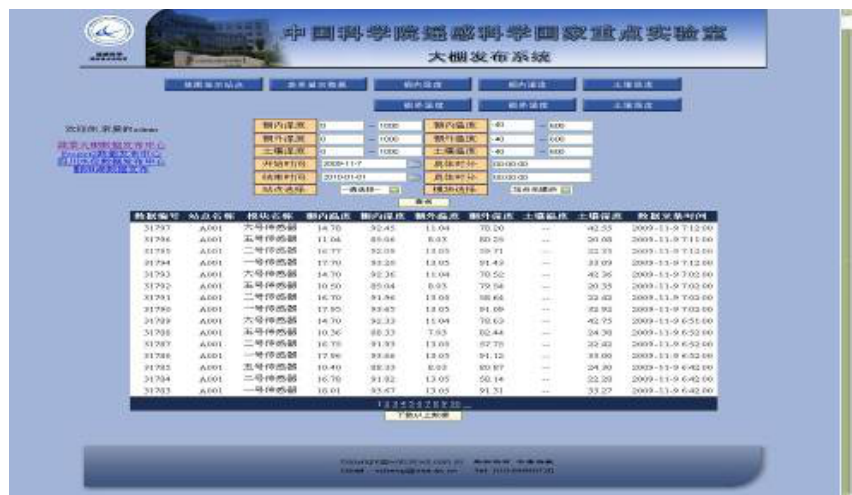
Figure 16. WEB Release System